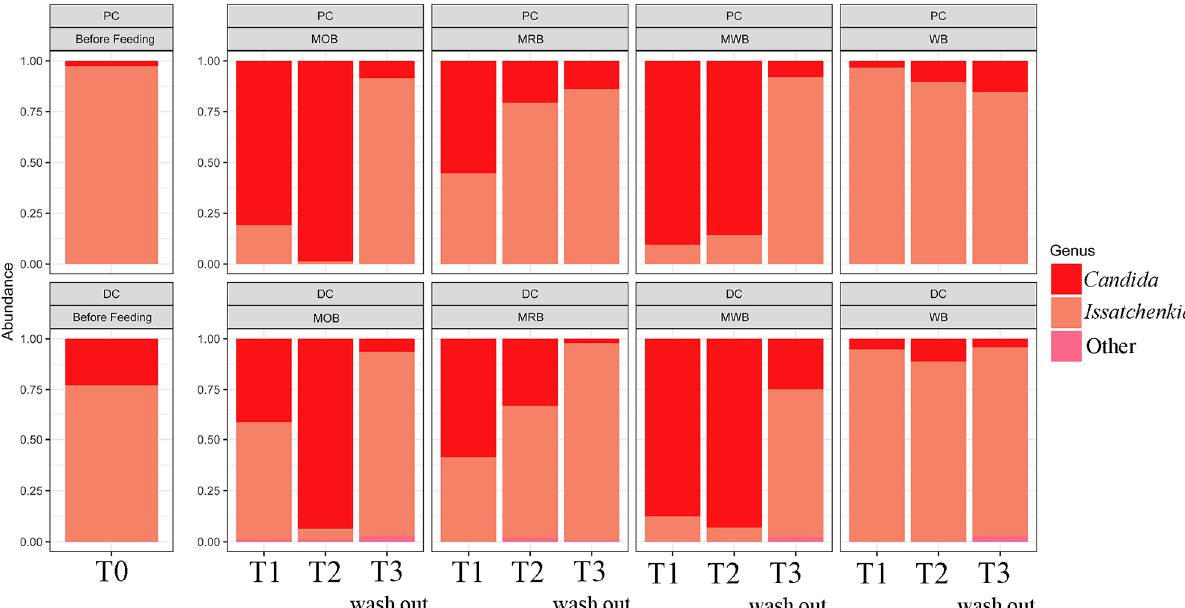
Figure 2. Relative abundance at genus level of the yeast microbiota, before (T0), during one (T1) and two (T2) weeks of feeding with MOB, MRB, MWB and WB, and after two weeks of wash out period (T3), in the PC and DC tracts.